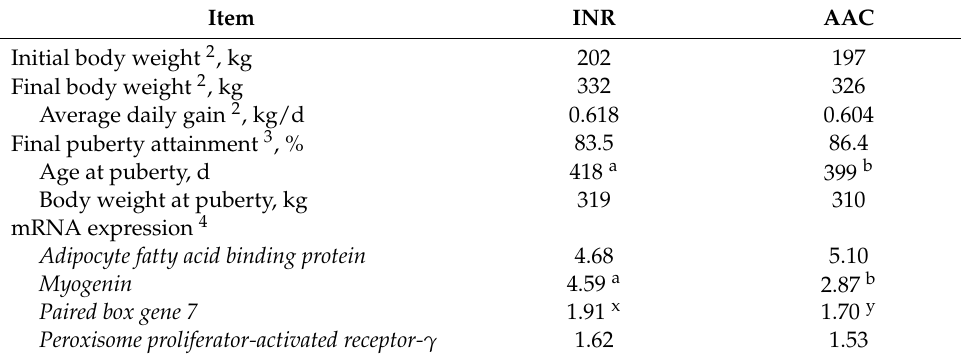
1 Adapted from Harvey et al. [85], and means within row with different superscripts differ at p ≤